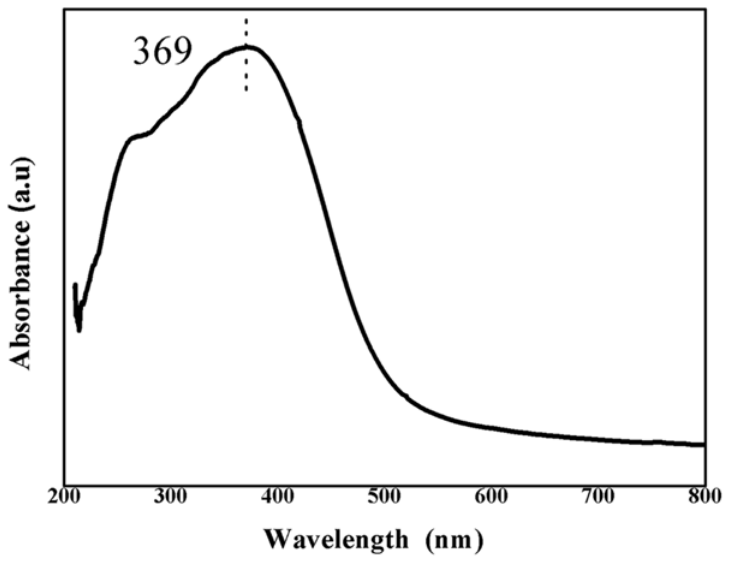
Fig 3. UV-Visible absorbance spectrum of prepared CeO 2